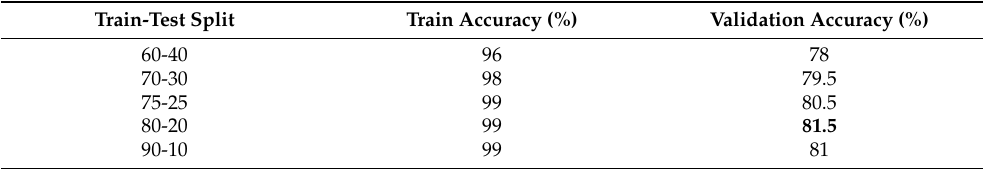
Table 2. Comparing patch-level accuracies for different train–test splits. Bold font value indicates the highest